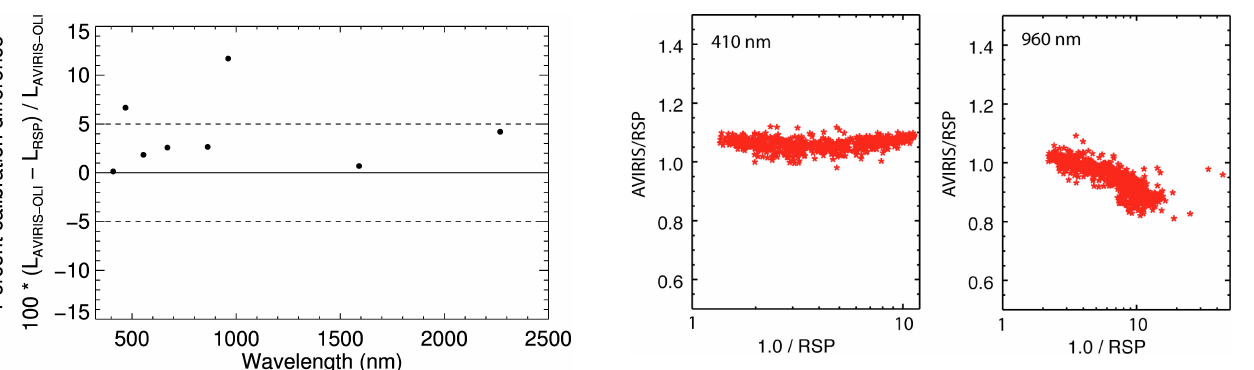
Figure 10. Percent difference between RSP and OLI-calibrated AVIRIS.